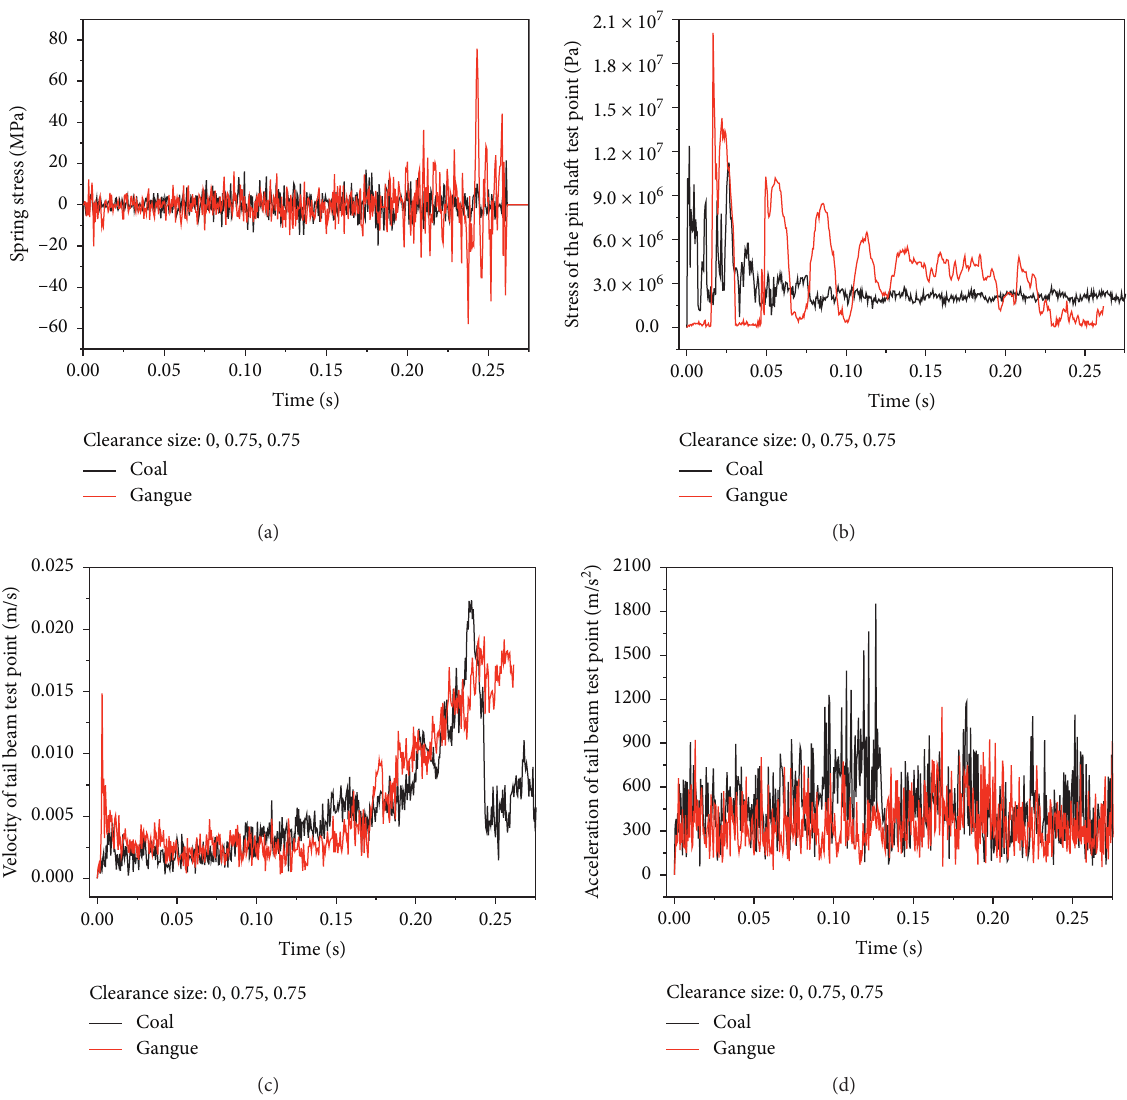
Figure 12: Impact contact response difference of the 2-clearance system. (a) Spring stress. (b) Stress of the pin shaft test point. (c) Velocity of the tail beam test point. (d) Acceleration of the tail beam test